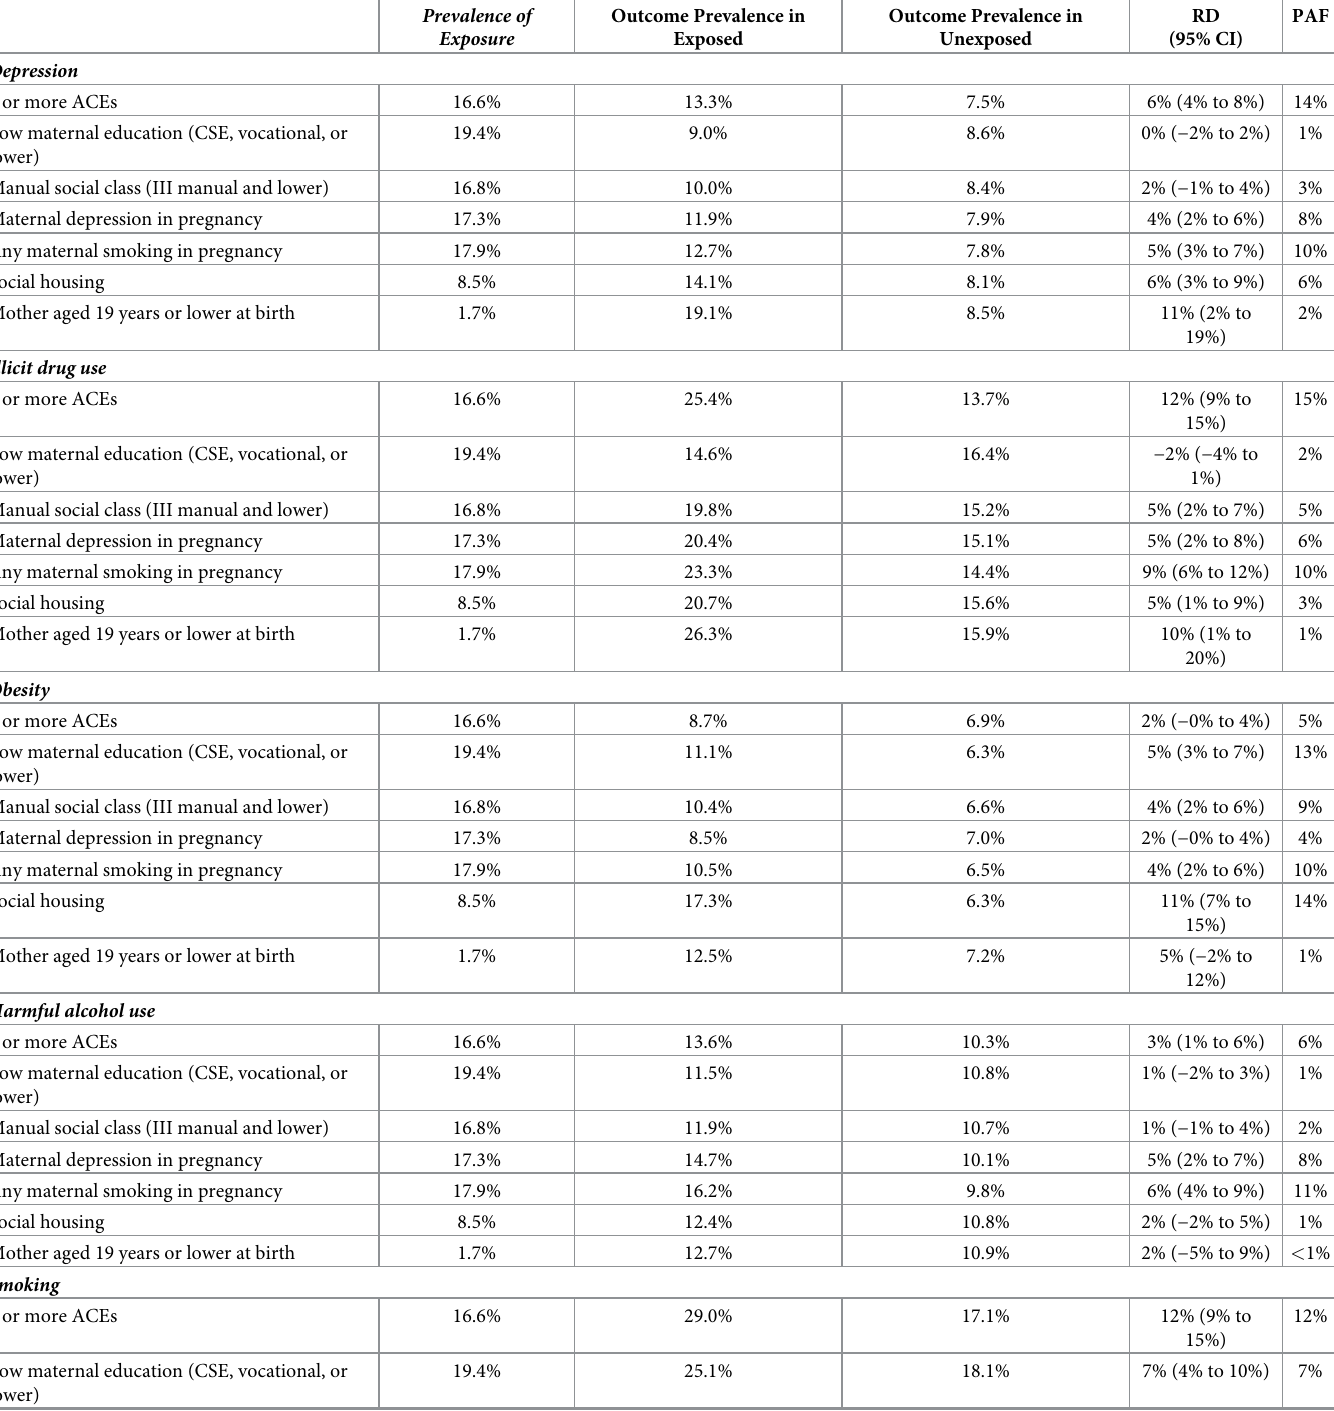
Table 3. Associations of ACEs and various sociodemographic markers with health and health risk behaviours on the RD scale and PAFs. PAF is the proportion of the people experiencing each outcome (depression, illicit drug use, obesity, harmful alcohol use, or smoking) who also experienced the ‘exposure’ (ACEs or sociodemo- graphic variable). PAF can be interpreted as the proportion of the outcome cases that could be prevented if the exposure was eliminated, assuming causality. Note that the reference categories in this table differ from those in other parts of the manuscript; here, the reference category is all other participants apart from those with the exposure (for example, the reference category for 4+ ACEs here is < 4